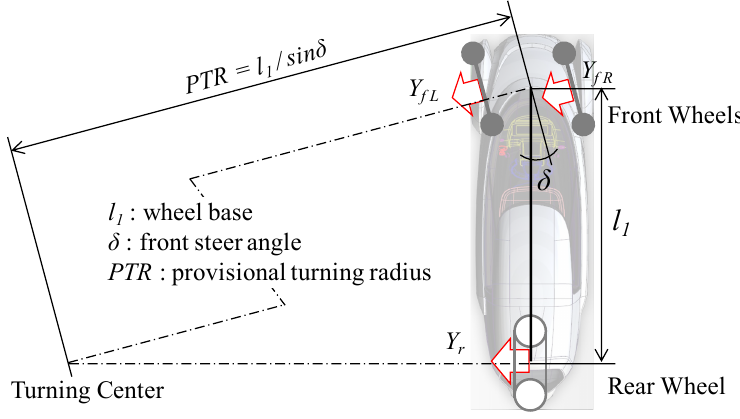
Figure 29. Energy consumption caused by cornering